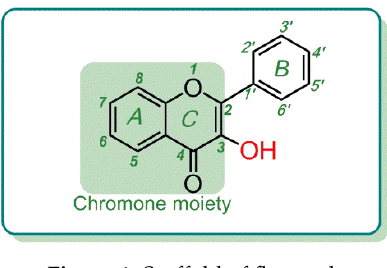
Figure 1. Scaffold of flavonol.